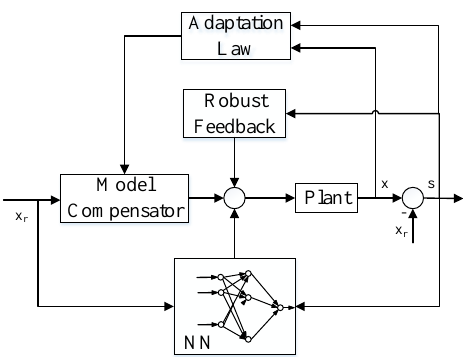
Figure 2. Structure of an adaptive robust neural network controller (ARNNC) control scheme.